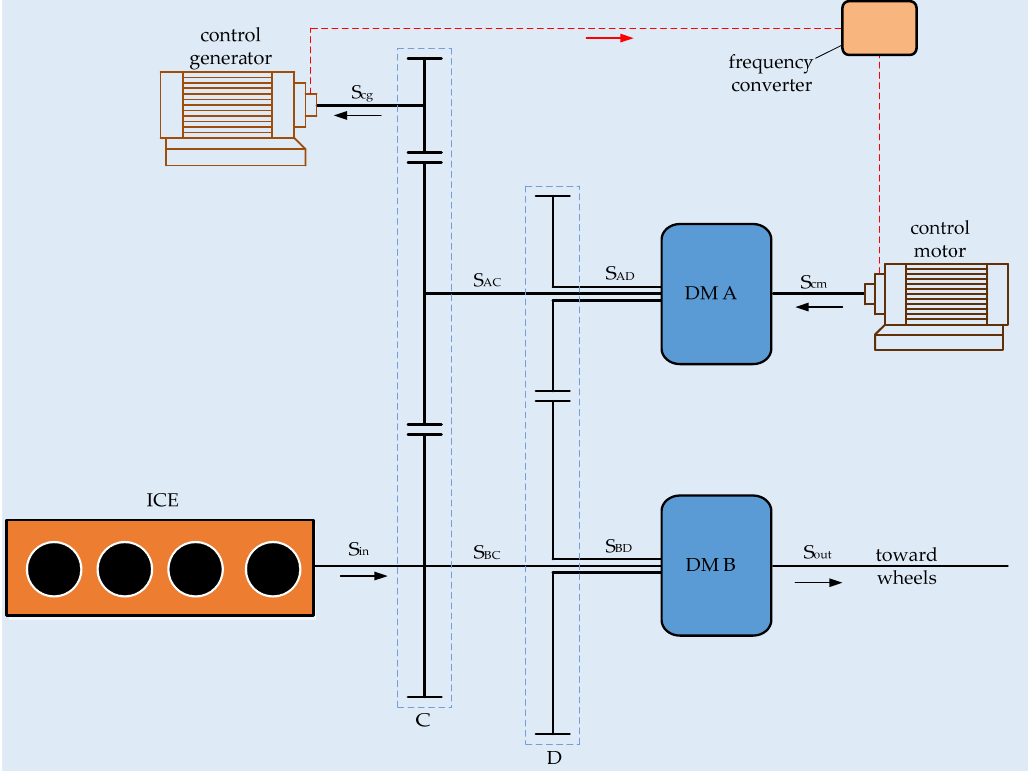
Figure 7. Topology of a hybrid drive train derived from the analyzed transmission.